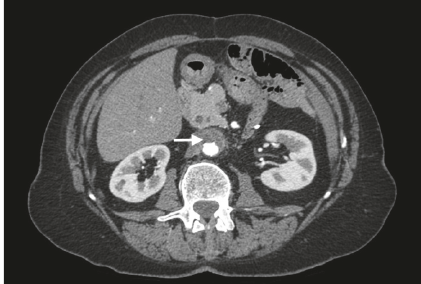
Figure 2: Abdominal CT scan (day 6) showing an increased periaorticinfiltrationhighlysuggestiveofinfectiousaortitis(arrow).